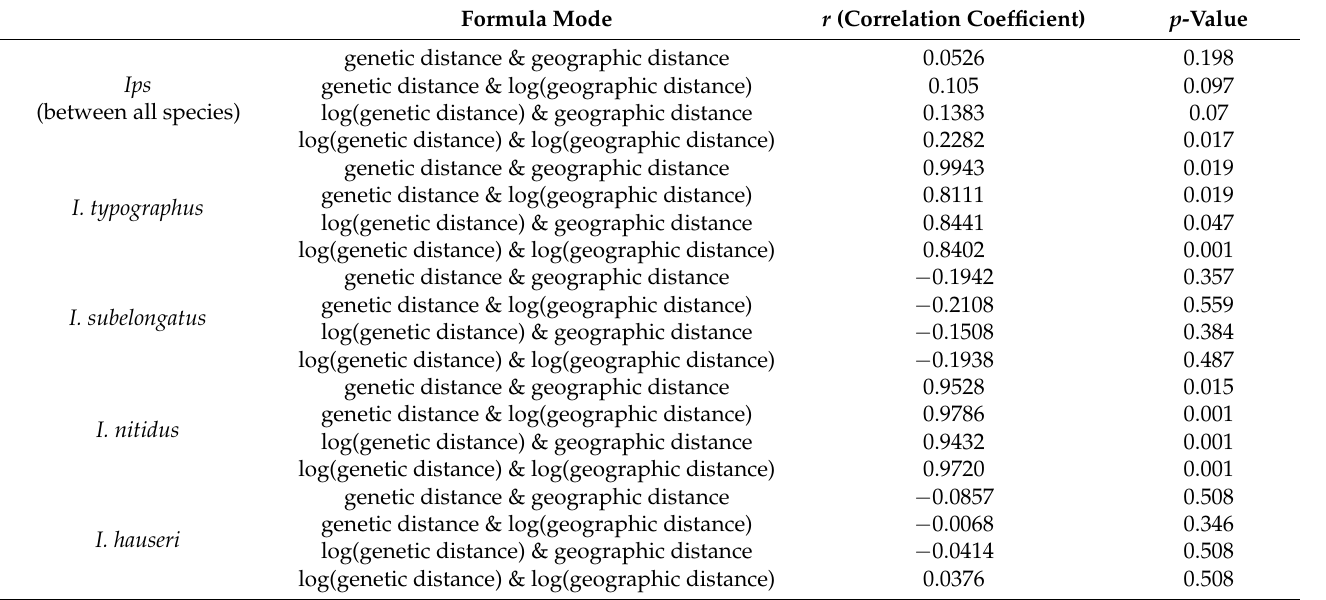
Table 3. The results of the Mantel test between genetic distance and geographic distance. Formula